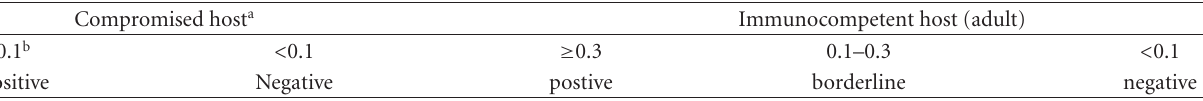
Table 4: Proposed Immunocompetence-stratified positive criteria and borderline zone for whole blood T-cell assay (QuantiFERON-TB Gold).